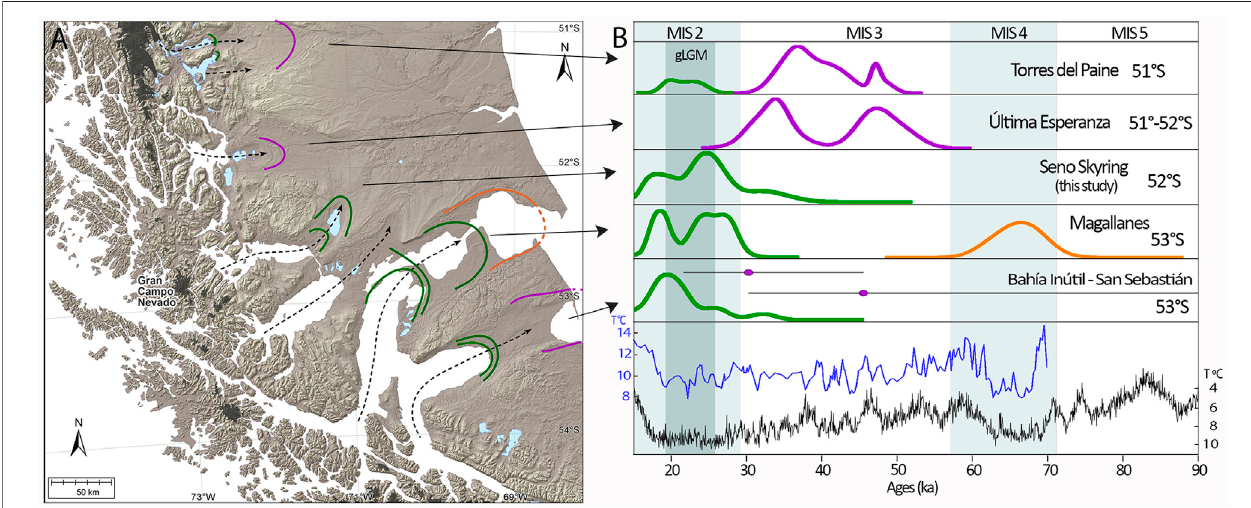
FIGURE 12 | Southern Patagonia ice lobe extents and timing of occurrence of the moraine belts during the last glacial period from 15 – 90 ka. (A) Map of major moraine belts which are coloured to match the geochronology in panel (B) . Orange corresponds to MIS 4, purple to MIS 3 and green to MIS 2. (B) Density functions (probability plots) of exposure ages of moraine boulders in Southern Patagonia moraine belts (this study; McCulloch et al., 2005b; Kaplan et al., 2008; Sagredo et al., 2011; García et al., 2018; Peltier et al., 2021). For the Bahía Inútil-San Sebastián ice lobe, the outer glacial margins were geochronological constrained through a cosmogenic nuclide depth pro fi le approach performed on the outwash plain associatedwiththeir respective moraine (Darvill et al., 2015). Theseages areindicated bya solid circle(purple)and theiruncertainty byahorizontal line.TheSea SurfaceTemperature (SST) curve (blue)isfrom anoff-shore coreinnorthwesternPatagonia at 41 ° S (Kaiser et al., 2005) and the east Antarctic temperature record (black) from EPICA Dome C (Jouzel et al., 2007).